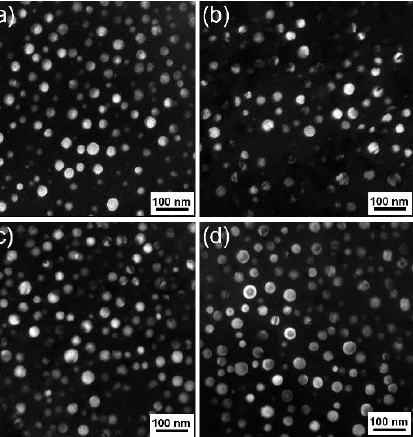
Figure 6. TEM dark fields of the γ′ precipitates ( a ) before tensile deformation and after tensile fracture at ( b ) room temperature, ( c ) 700 °C, and ( d ) 750 °C, respectively.